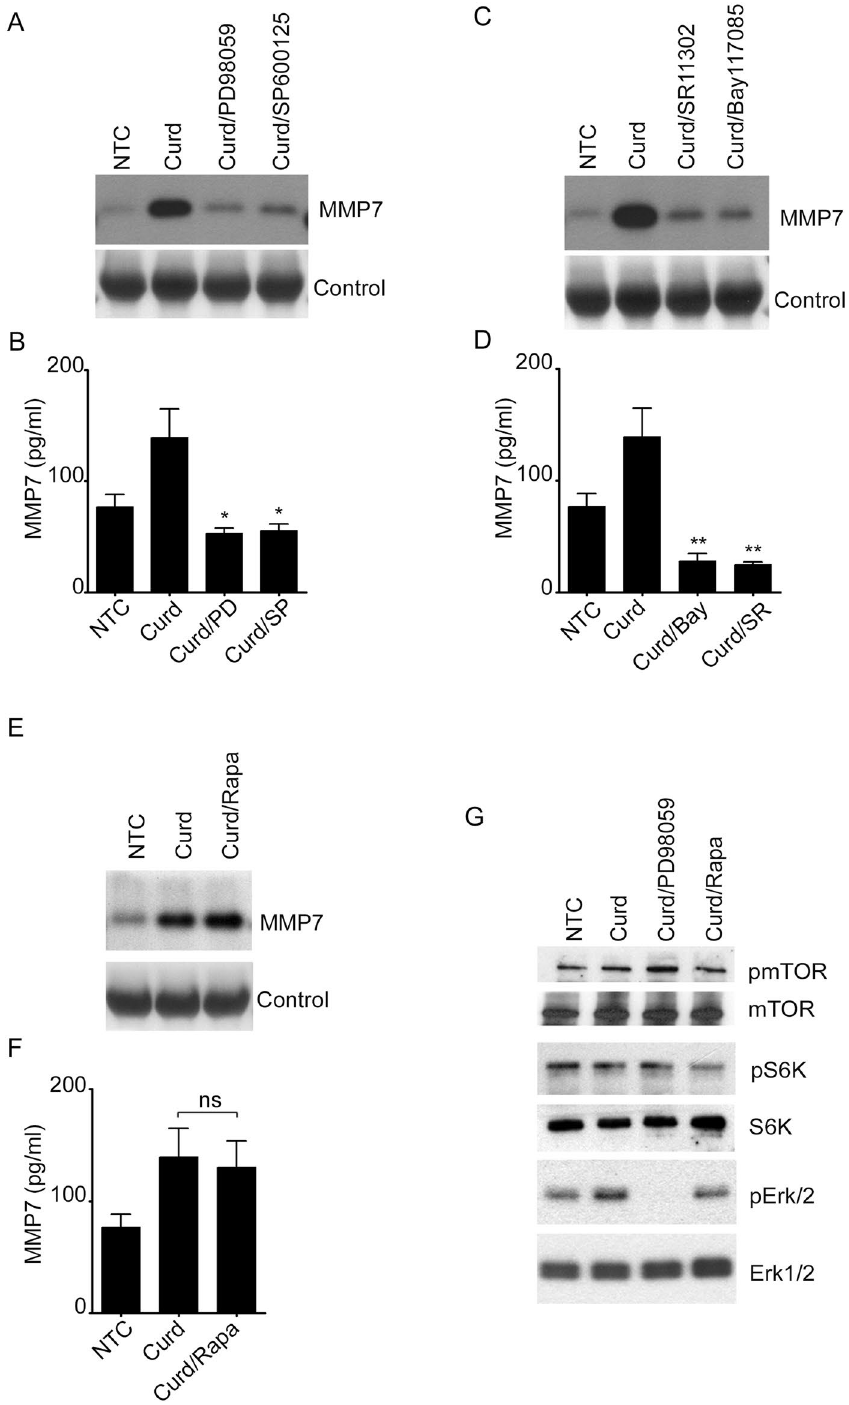
Figure 6. Curdlan induces MMP7 in an mTOR-independent manner. MMP-7 secretion was measured by immunoblotting ( A , C , E ) or ELISA ( B , D , F ) in the cell supernatant of unstimulated or Curdlan-stimulated cells. Cells were pre-incubated with 30 μ M PD98059, 20 μ M SP600125, 10 μ M SR11302, 10 μ M Bay 11-7085 and (100 nM) Rapamycin prior to Curdlan stimulation as indicated. ( G ) Phosphorylation of mTOR, S6K and ERK were detected by immunoblotting in the cell lysate of Curdlan-stimulated cells in the presence of 30 μ M PD98059 and (100 nM) Rapamycin. Total mTOR, S6K and ERK were used as controls. Data are representative of at least three independent experiments. * p < 0.05, ** p < 0.01, ns, not significant ( p >